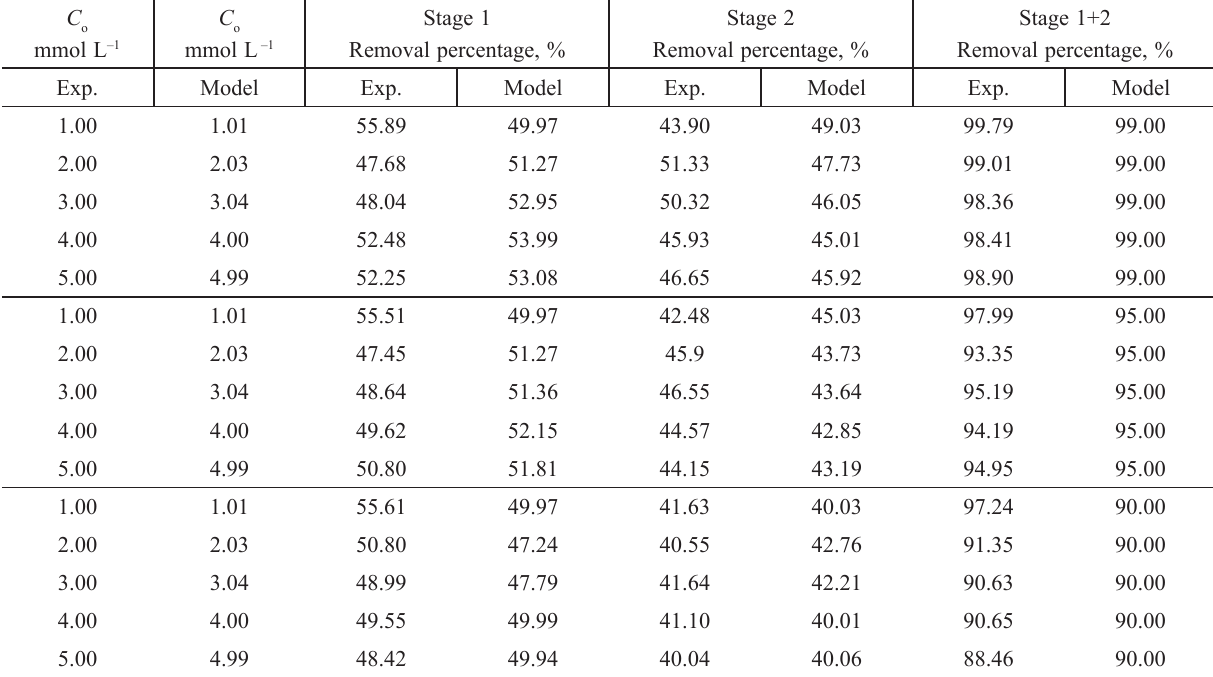
Table 6 – Comparison of experimental and calculated values of removal efficiency obtained in stage 1 and stage 2 for different initial concentrations and removal percentages for cadmium C